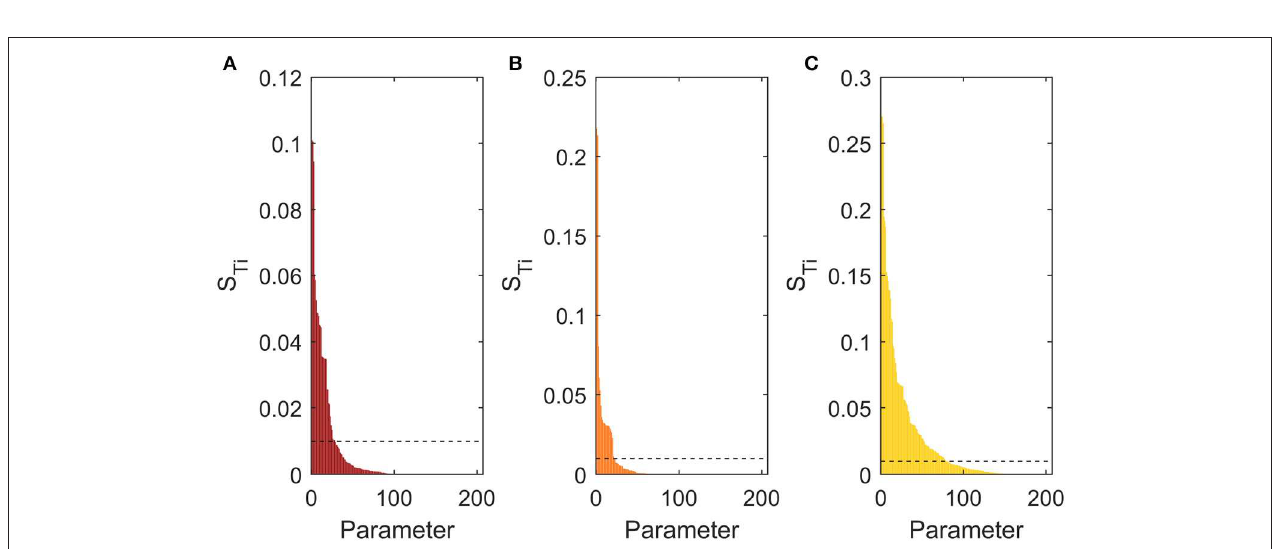
FIGURE 6 | Morris method results of the k = 205 parameters on HU min (A,B) , CU min (C,D) , T pp (E,F) . Figures to the left report the µ SEE - σ SEE relations. Figures to the right show the µ ∗ SEE values sorted in descending order. The dotted lines indicate the proposed cut-off thresholds.